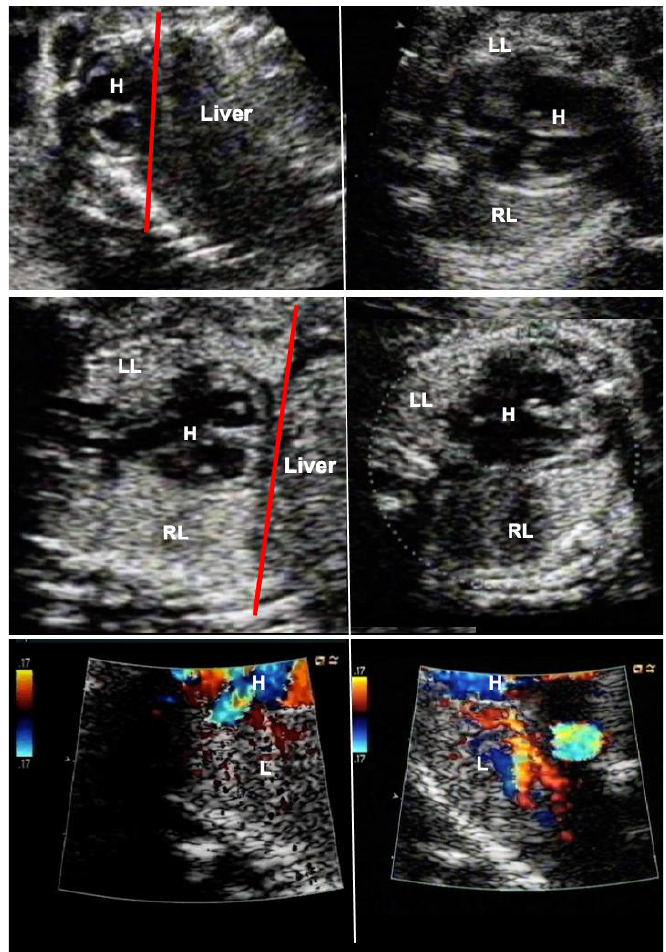
Figure 4. Effect of FETO at 27 weeks of gestation in a fetus with severe pulmonary hypoplasia from anhydramnios after rupture of membranes at 15 weeks of gestation. Top left —severe compression of the fetus has resulted in a displacement of the heart–lung base to the level of the third to fourth rib (red line). Top right —there is pseudocardiomegaly and at the level of the four-chamber-view, the left lung (LL) can hardly be seen. Middle left —after one week of FETO, the lung has regained volume such that the heart–lung base now lies at the level of the 7th–8th rib (red line). Middle right —as a result, the four-chamber-view has normalized, and the left lung can easily be seen. (RR—right lung). Bottom left —color Doppler imaging at a low Nyquist limit (17 cm/sec) demonstrates barely any color flow signals within the lungs one day after FETO. Bottom right —on the third day of FETO, color flow signals are clearly present in the fetal lung, heralding a better prognosis. As soon as fetal pulmonary vasodilatation can be provoked by diagnostic materno–fetal hyperoxygenation, the fetus is scheduled for fetoscopic balloon removal, delivery, and postnatal